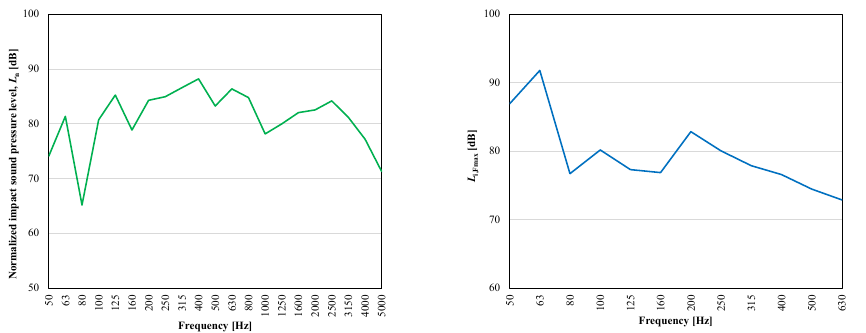
Figure 16. Simulated normalized sound reduction index (Equation (7)) and energy average maximum impact sound pressure level (Equation (9)).